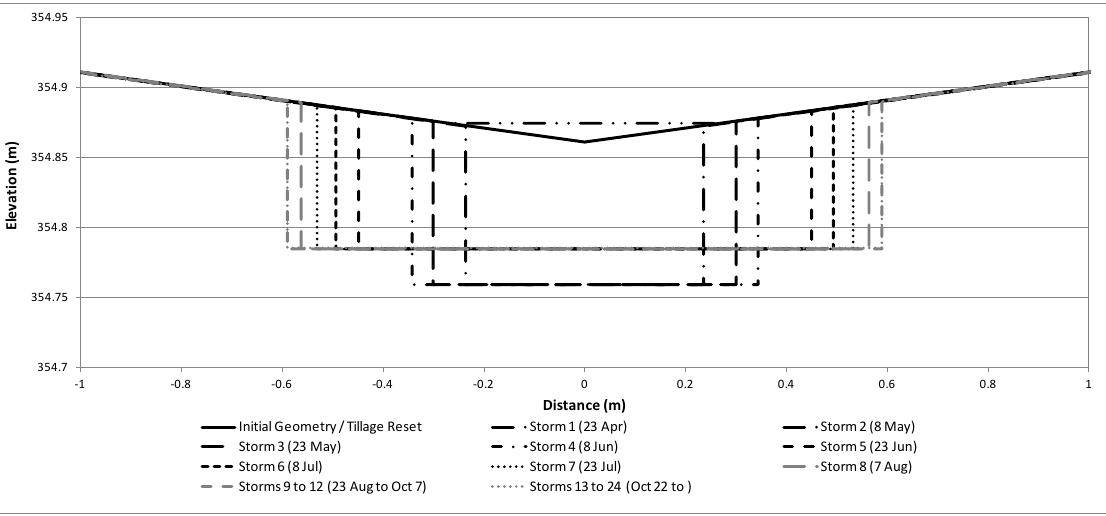
Fig. 2 Cross-sections following selected runoff events for CS#2 (Fig. 1) in simulations without a grassed waterway.